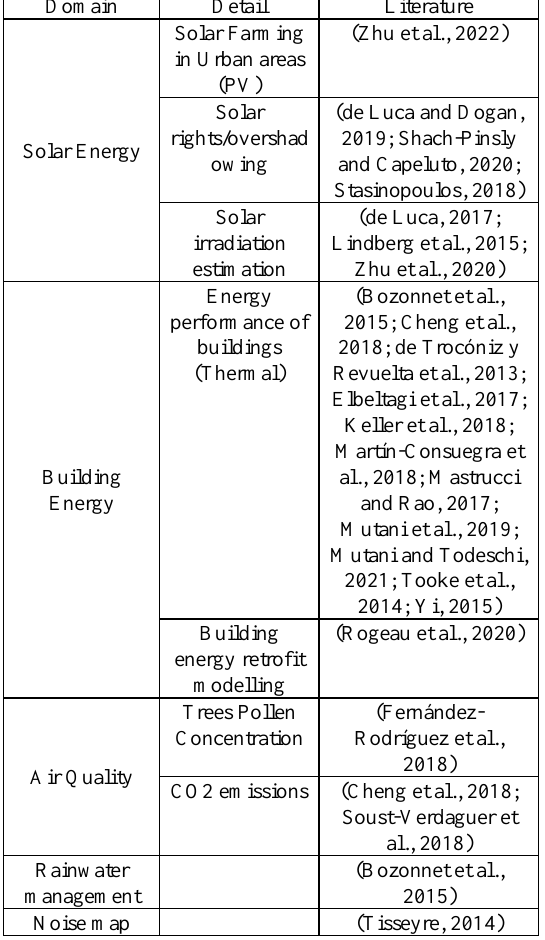
Table 1 . Application domains of 3D city and building models in urban